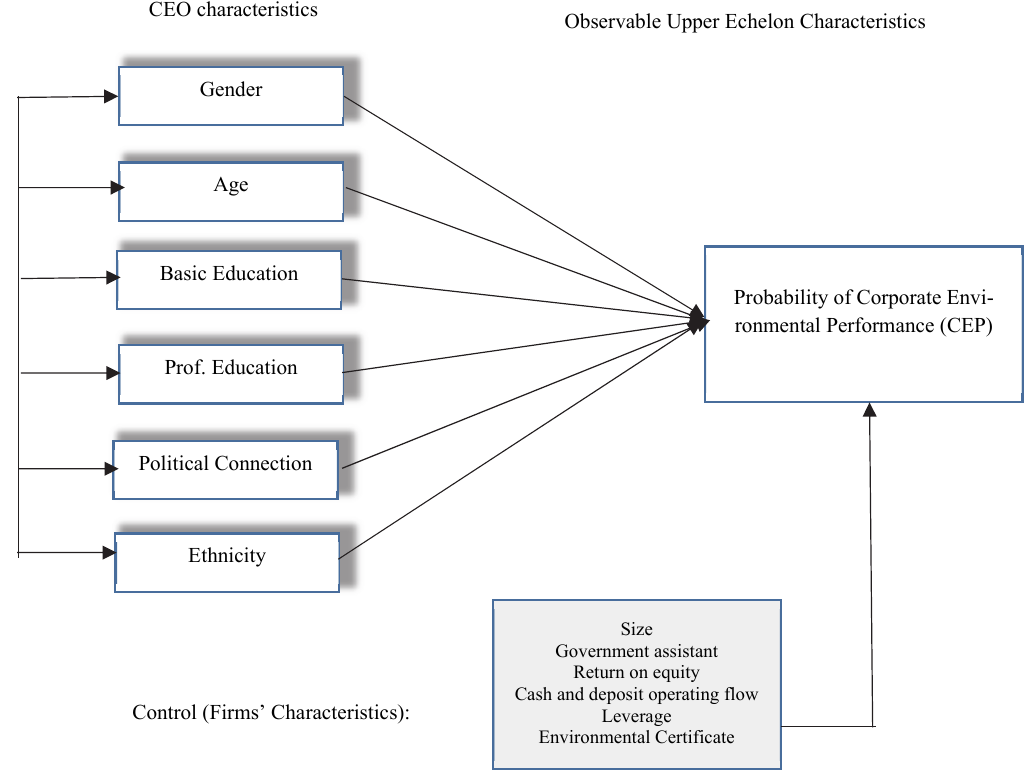
Fig. 1. Conceptual model: Relationship between biographical characteristics of CEOs, factors affecting CEP, and the proba- bility of